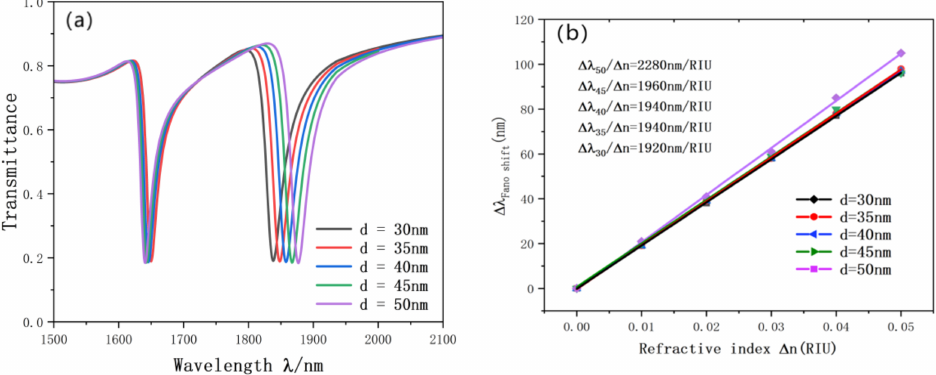
Figure 9. ( a ) Transmission spectrum of g variation; ( b ) the sensitivity of d changes to fit the line. In order to further study the effect of the coupling gap. We superposed the coupling gap layer by layer from 10 nm to 30 nm. The research coupling results of the SRRDR and waveguide straight line are shown in the Figure 10a. The figure shows that with the continuous increase of g, the transmittance of the most obvious Fano resonance curve is increasing, which indicates that the coupling performance is greatly weakened. This will inevitably lead to a sharp deterioration in the performance of the sensor. In addition, the Fano curve is blue shifted. FWHM also tends to narrow. The FWHM diagram is shown in Figure 10b.